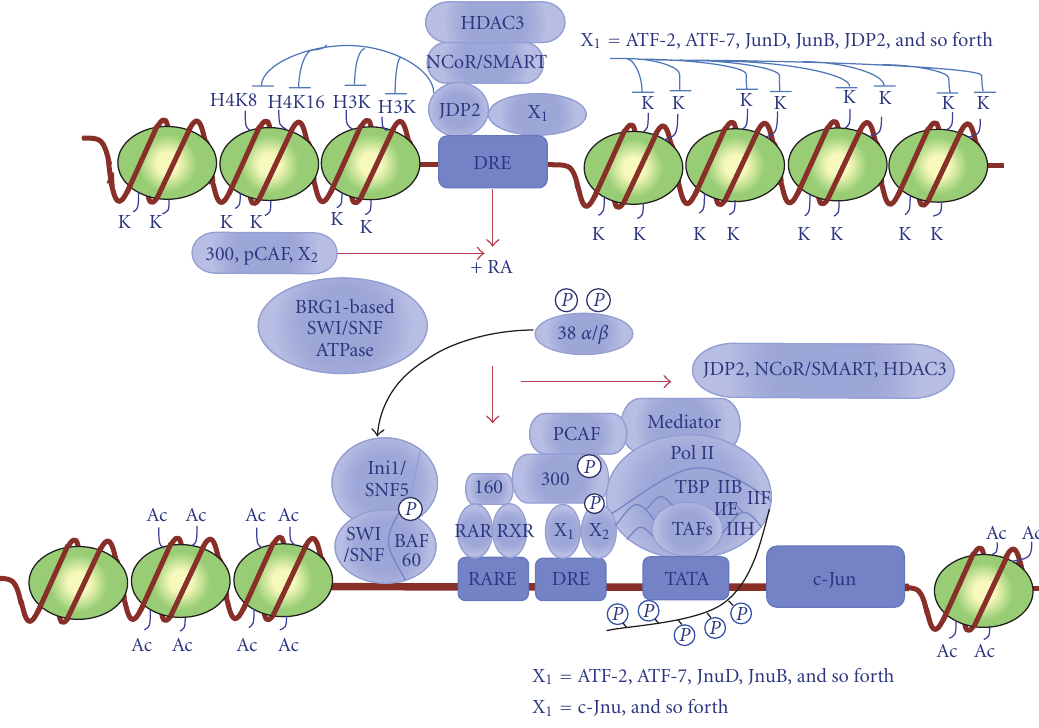
Figure 1: Schematic representation of the signal pathways of retinoic acid- (RA-) induced (RA-induced) di ff erentiation of mouse embryonic carcinoma F9 cells. At the undi ff erentiation stage of F9 cells, HDAC3, NcoR/SMART, and JDP2 were recruited on the DRE (di ff erentiation response element) in the promoter region of the c-jun gene to induce the heterochromatin. In the response to retinoic acid (RA), the signals of mitogen-activated kinase (MAPK; phosphorylated (p38( α / β )), BRG1-based SWI/SNF ATPase complex, Ini1/Snf5/SWI/SNF/BAF60 complex, p160 hormone coactivator (RARE/RXRE binding), and p300/PCAF complex were recruited to the DRE element of the c-Jun promoter and then Mediator, Pol II complex (IIB, IIF, IIE, IIH complex), TBP complex, and some TAF complex (ATF12, TAF 4 etc), and recruited and Pol II complex is elongated with phosphorylation of the carboxy terminal domain (CTD) of Pol II, and then c-Jun genes are finally activated. Ac, acetylated residues; K, lysine residues of histone; H3K, lysine residues of histone H3; H4K8, lysine residue at position 8 of histone H4; H4K16, lysine residue at position 16 of histone H4; X1 = ATF-2, ATF-7. JunD, JunB, JDP2, and so forth; X2 = c-Jun and so